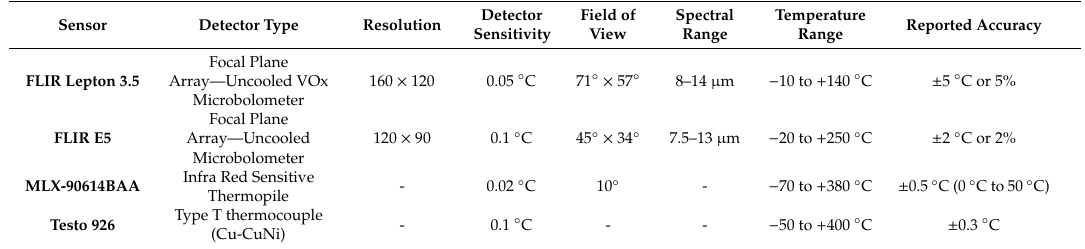
Table 1. Detailed specifications of temperature sensors used during the study